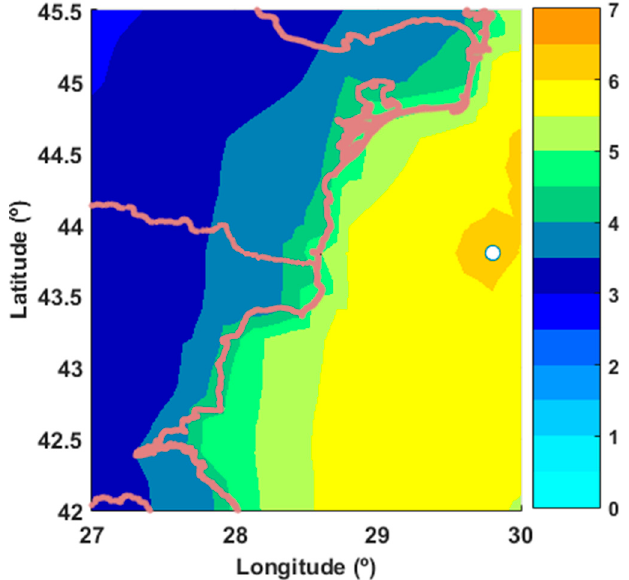
Figure 10. The spatial distribution of the average U 10 (m/s) over the Romanian coastal area. Results computed for the 20-year time interval from January 1998 to December 2017.